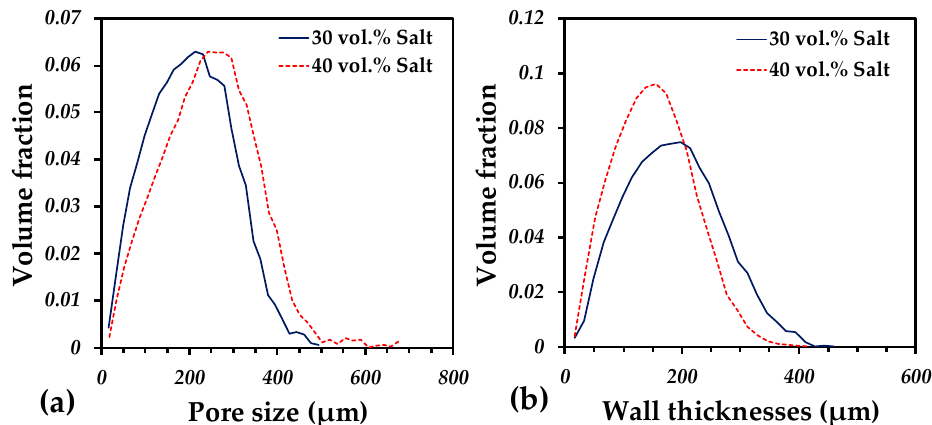
of salt particles, ( a ) Ti20Ta; ( b ) Ti25Ta; and ( c ) Ti30Ta.